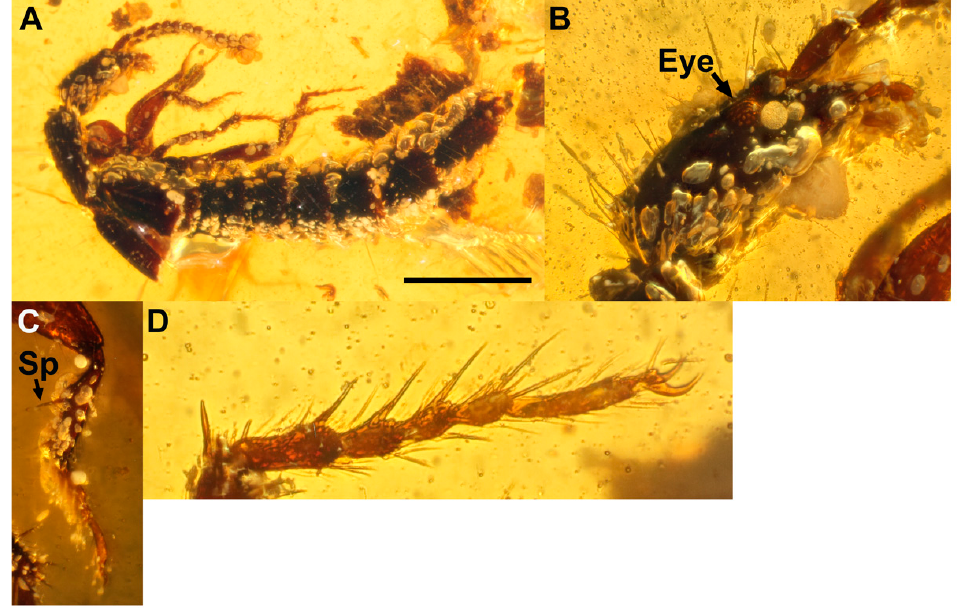
Figure 4. Coomania enkarsios sp. nov. Paratype SNUC-Paleo-0106. ( A ), lateral view. ( B ), close-up of head. ( C ), front leg. ( D ), right metatarsus. Scale bar-1 mm. Sp-spur. Coomania yini sp. nov. (Figure 5)